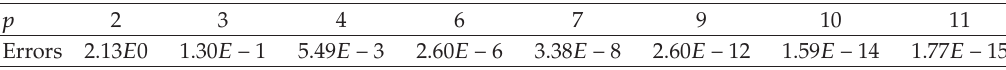
Table 4: The errors between exact and approximate fundamental eigenvalue for various p and for h (cid:5) 1 and n (cid:5) 0 in Example 3.1.